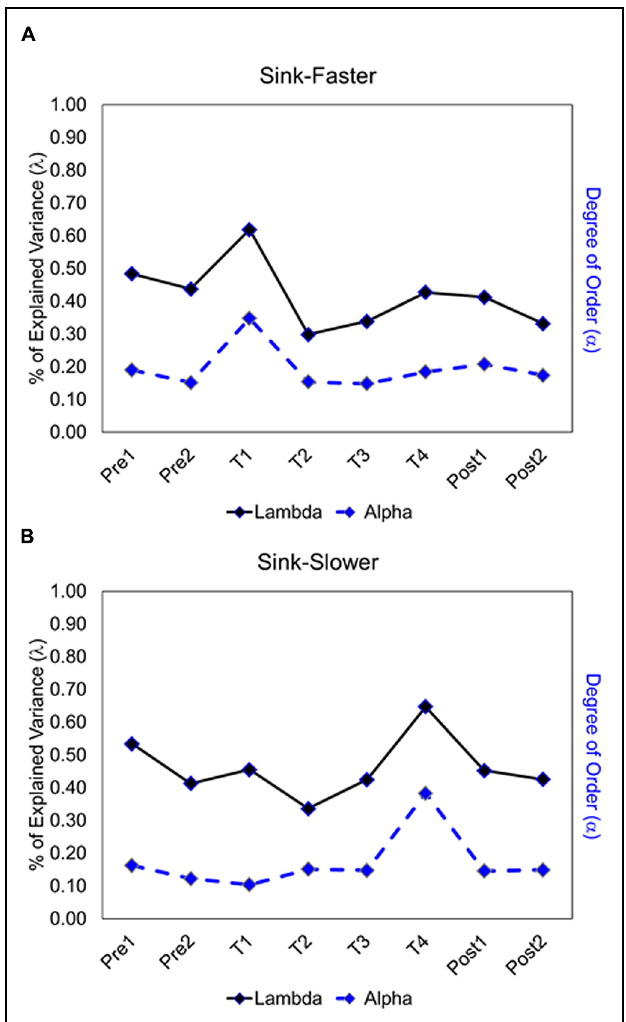
FIGURE 8 | Fluctuations of degree of order and % of explained variance of the first dimension by segment in the sink-faster (A) and the sink-slower condition